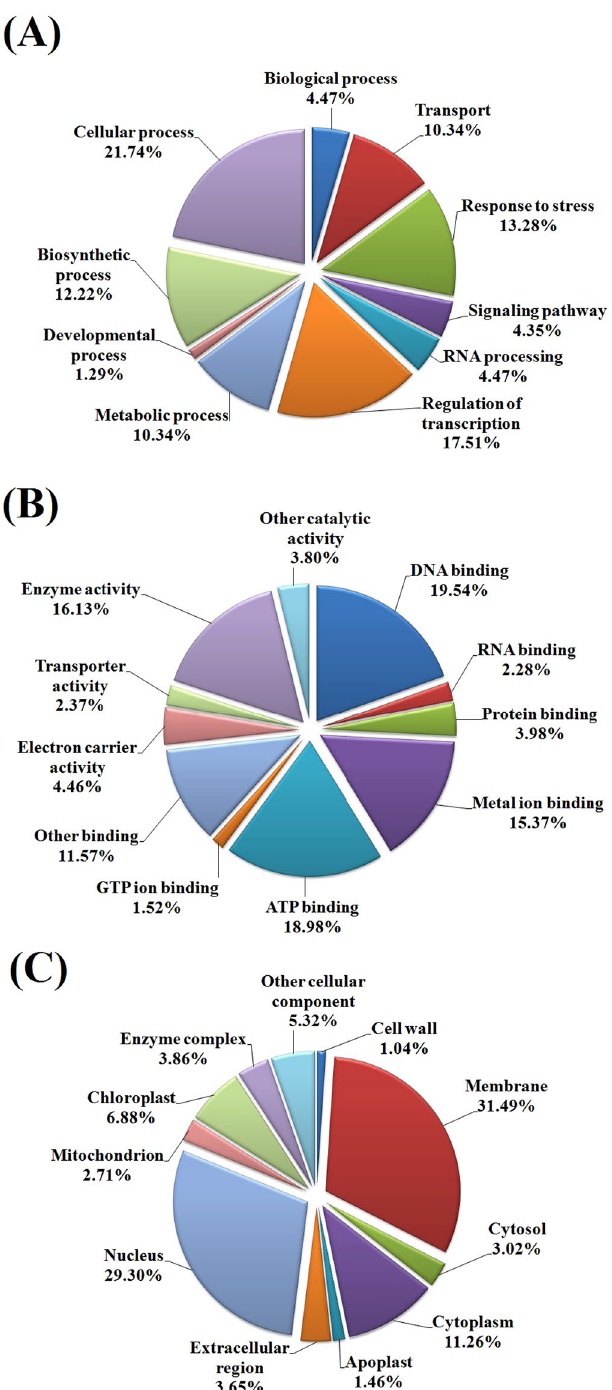
Figure 6. GO enrichment analysis of the predicted potential targets of differentially expressed miRNAs in Camellia sinensis . Categorization of the miRNA target genes into biological processes ( A ), molecular functions ( B ) and cellular components ( C ) was